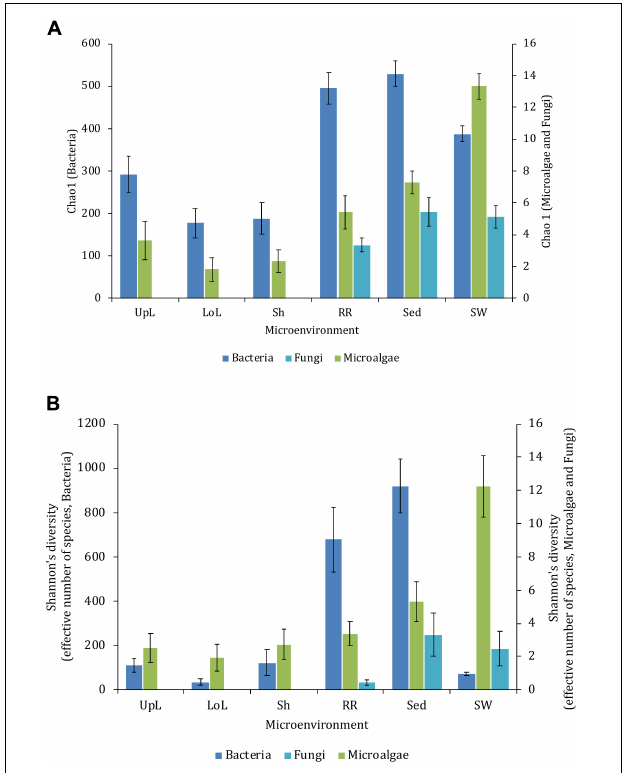
FIGURE 2 | Microbial mean alpha diversity across seagrass microenvironments. Multiple comparisons between Chao1 diversity (A) and Shannon’s diversity index (B) , calculated for each taxa and microenvironment separately, were tested for statistical significance with Permutational Multivariate Analysis of Variance (PERMANOVA, Minkowski metric distance matrix and nested design). Mean values for each microenvironment are shown, and error bars reflect the standard error of the